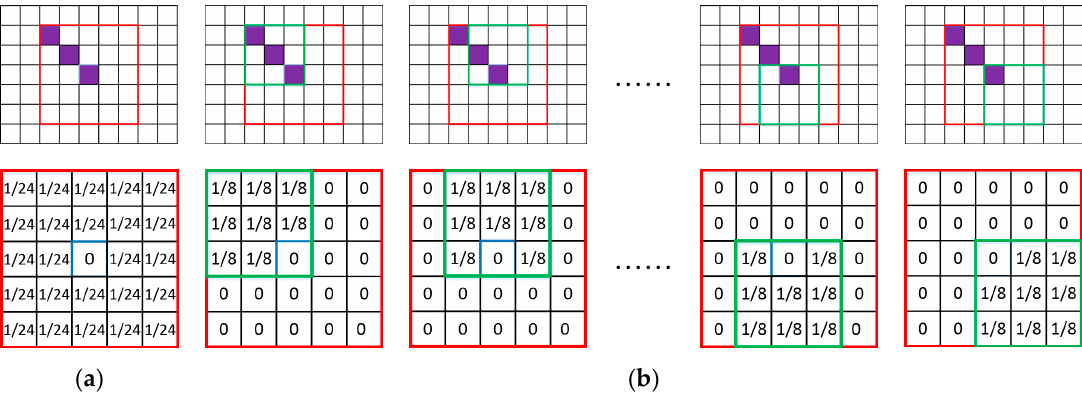
Figure 2. Schematic diagram of a single local window and multiple local windows and the Figure2. Schematicdiagramofasinglelocalwindowandmultiplelocalwindowsandthecorresponding corresponding filters ( N = 5): ( a ) single local window; ( b ) multiple local windows. filters ( N = 5): ( a ) single local window; ( b ) multiple local